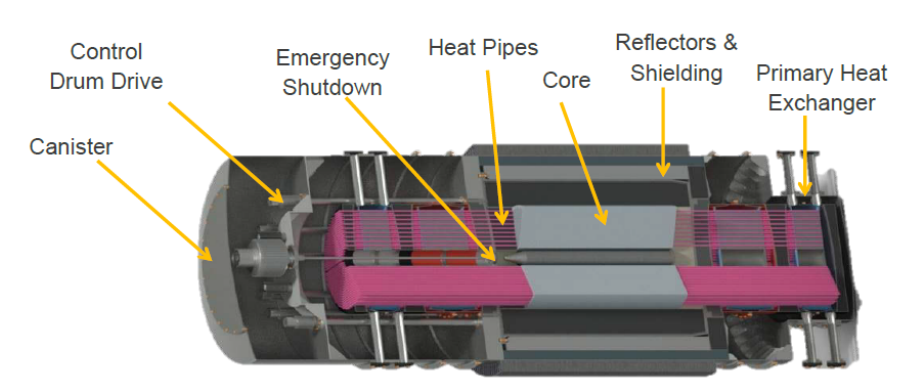
Figure 3. eVinci micro-reactor cutaway. Source: